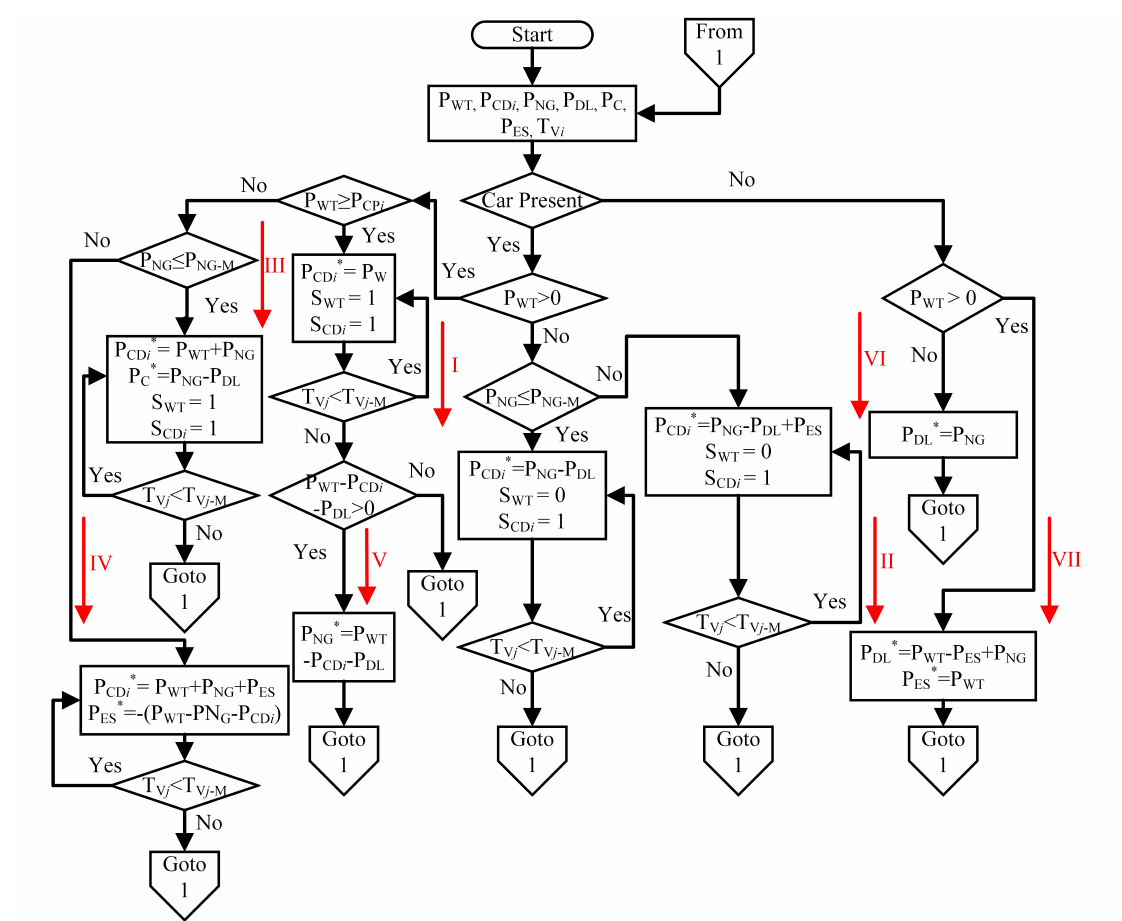
Figure 9. Flow chart of the proposed